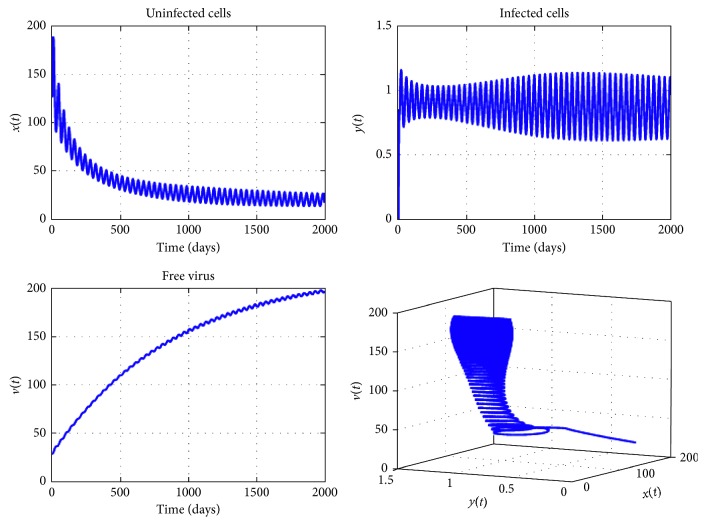
Dynamics of virotherapy when R0=1,5, β0=10−3, β1=10−5, β2=2 × 10−5, β3=3 × 10−5, β4=4 × 10−5, τ1=0.2, τ2=1, τ3=2, and τ4=3. The initial conditions are x(0)=127, y(0)=0, and v(0)=30.